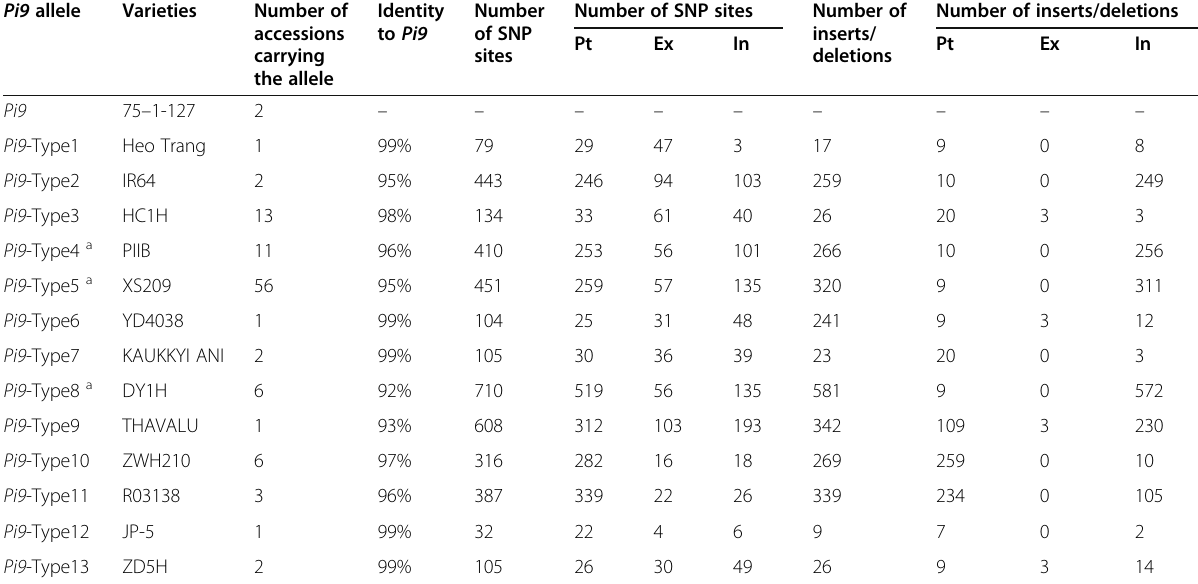
Table 1 Summary of SNP and different alleles of the Pi9 gene in different species Pi9 allele